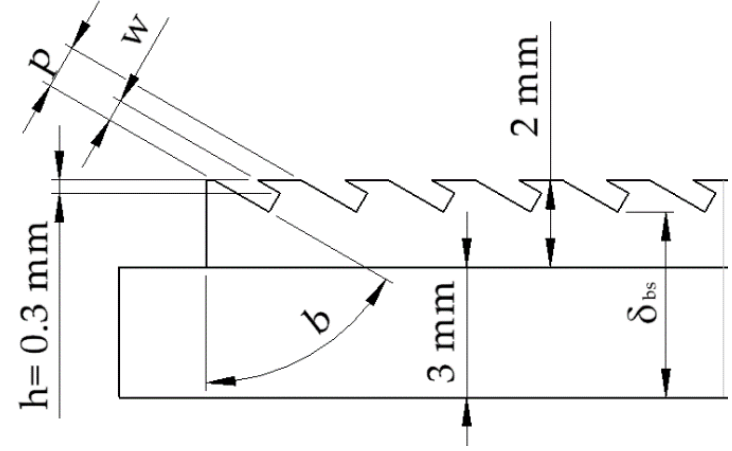
Figure 2. Surface photographs: ( a ) MC-0.5-0.3-1.0-60; ( b ) MC-0.5-0.3-1.0-30; ( c ) MC-0.5-0.3-1.0; ( d ) smooth surface.